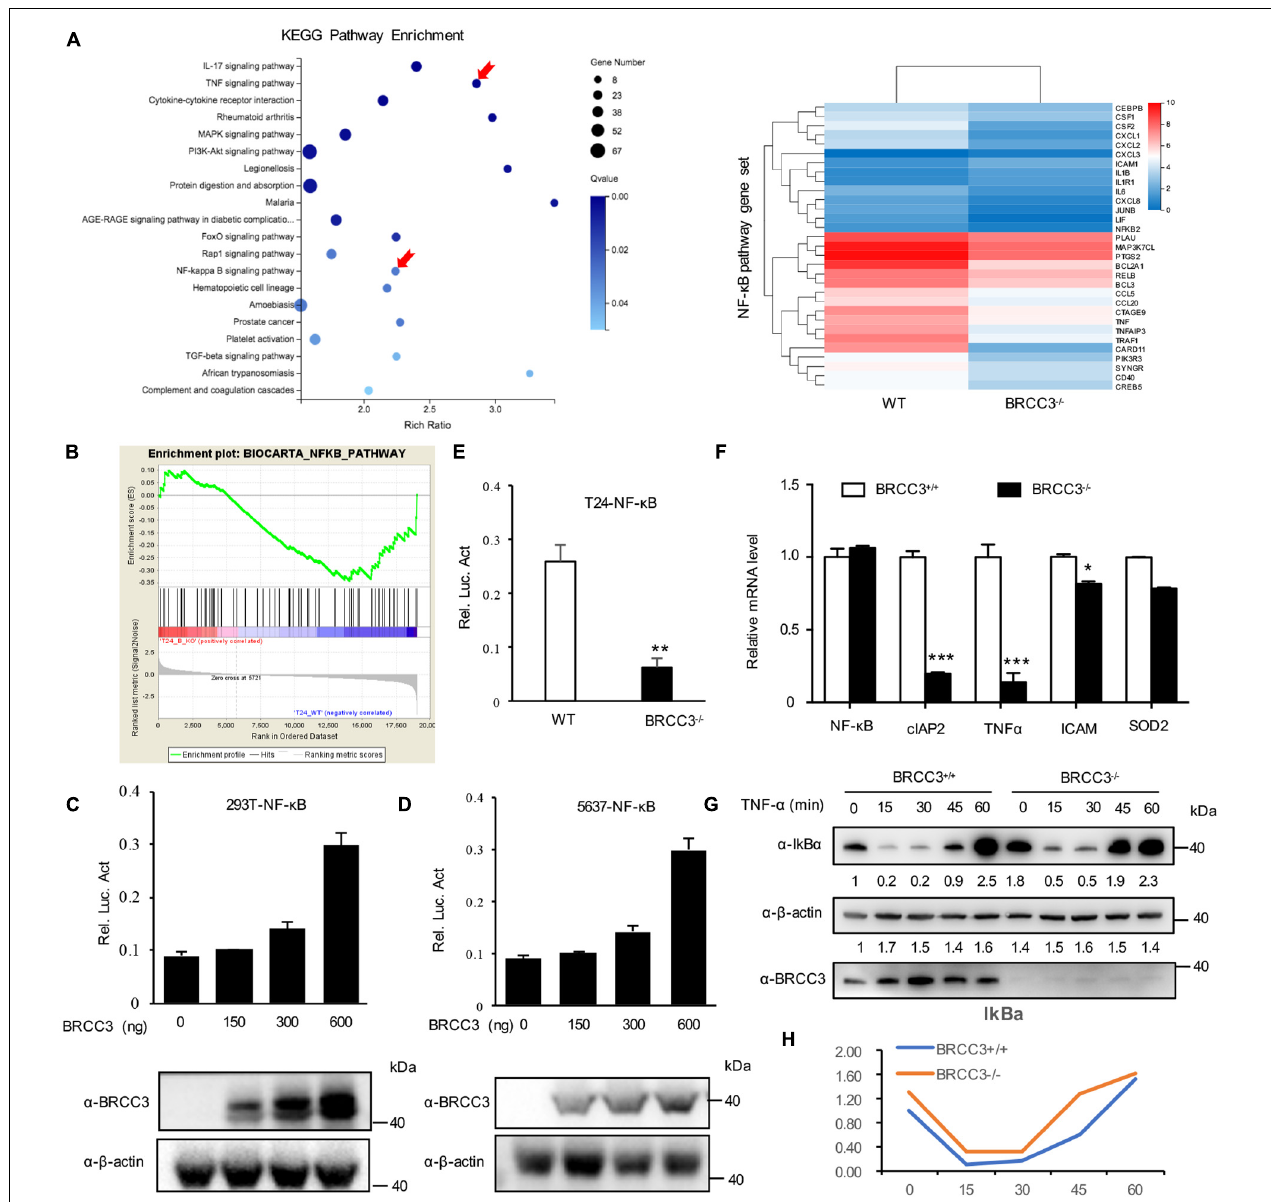
FIGURE 4 | Knocking out of BRCC3 resulted in inactivation of the NF- κ B signaling pathway. (A) KEGG pathway enrichment analysis was used to assess wild type and BRCC3 − / − bladder cancer cells. (B) GSEA identified NF- κ B pathway-related gene sets enriched in the wild-type cells. (C) BRCC3 promotes the transcriptional activity of NF- κ B. 293T cells were transfected with an NF- κ B reporter firefly luciferase plasmid (200 ng), pRL-TK (10 ng) and the indicated amounts of a BRCC3 plasmid. Reporter assays were performed 48 h after transfection, and the results are presented as the NF- κ B/TK luciferase activity. Data were analyzed employing one-way ANOVA and presented as the means ± standard error ( n = 3/group). (D) BRCC3 promoted the transcriptional activity of NF- κ B in bladder cancer 5637 bladder cancer cells. The experiments and data analyses were performed as in (C) . (E) BRCC3 ablation inhibited the transcriptional activity of NF- κ B. (F) The BRCC3 deficiency blocked the transcription of NF- κ B-targeted genes in the T24 cells. The expression levels of the indicated NF- κ B-targeted genes were examined by RT-qPCR in BRCC3 − / − T24 cells and wild type T24 cells. (G) BRCC3 deficiency reduced the degradation of I κ B α under TNF α stimulation. BRCC3 − / − T24 cells and wild type T24 cells were treated with 5 ng/ml TNF α for indicated time, and then the cell total protein lysis was analyzed by immunoblotting assays. (H) Quantitative data show the relative protein levels of I κ B α in (G) . Statistical analysis was conducted using a t -test. The means ± standard error from three independent experiments is shown. * P < 0.05, ** P < 0.001, and *** P < 0.001 compared with controls.